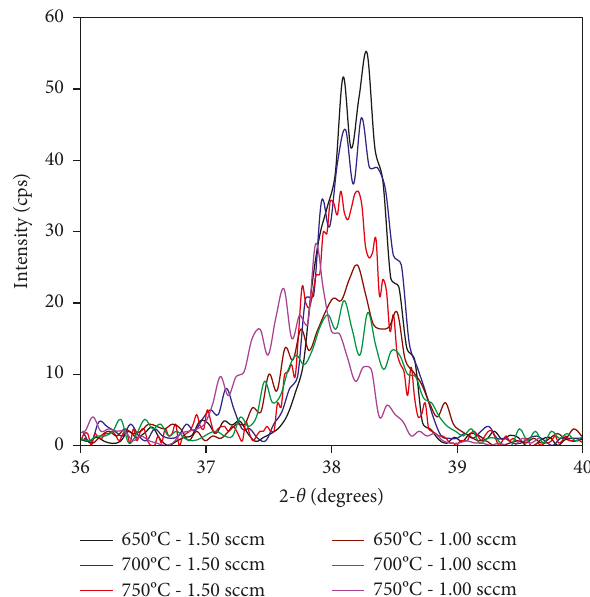
Figure 4: High-resolution rocking curves corresponding to plane of β -Ga 2 O 3 of films grown at 650, 700, and 750 ° C at fluxes of 1.0 and 1.5sccm.